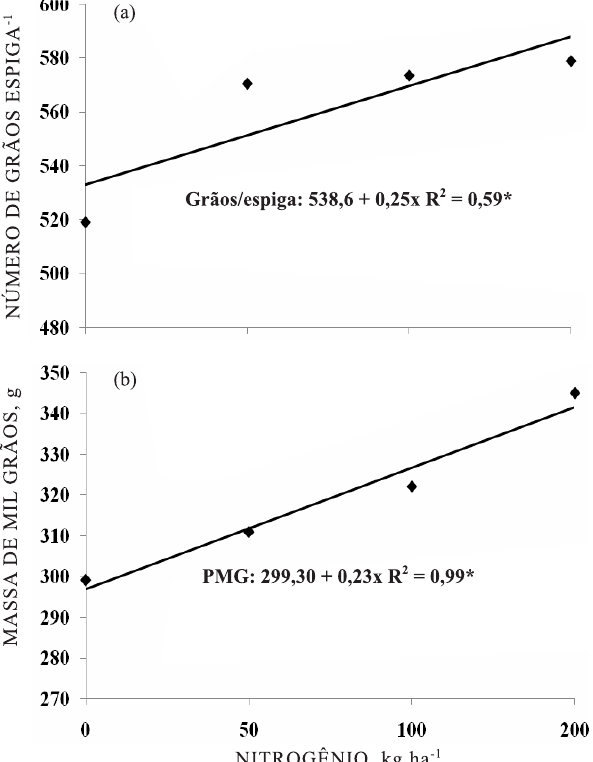
Figura 2. Número de grãos/espiga (a) e massa de mil grãos (b) do colmo principal em função da quantidade de N aplicada em cobertura na safra 2008/09. Regressões significativas a 5